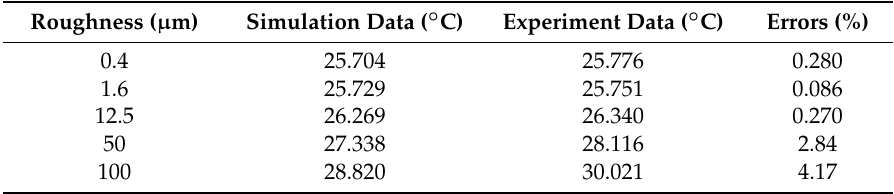
Table 2. Comparisons between simulation and experimental data.